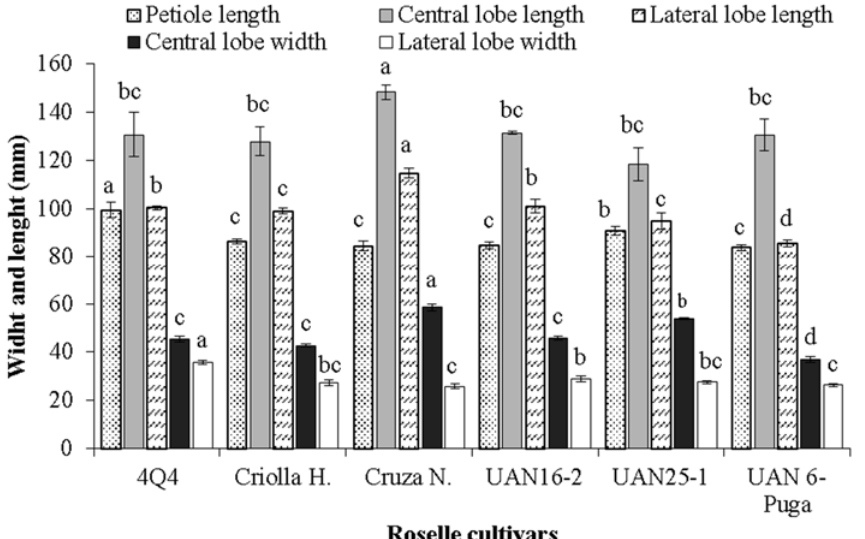
Figure 5. Length and width of lobes and foliar surface area of different cultivars of roselle. Different letters on bars corresponding to the same response variable indicate significant differences between cultivars according to the Tukey test ( p ≤ 0.05). Vertical bars correspond to the standard deviation.